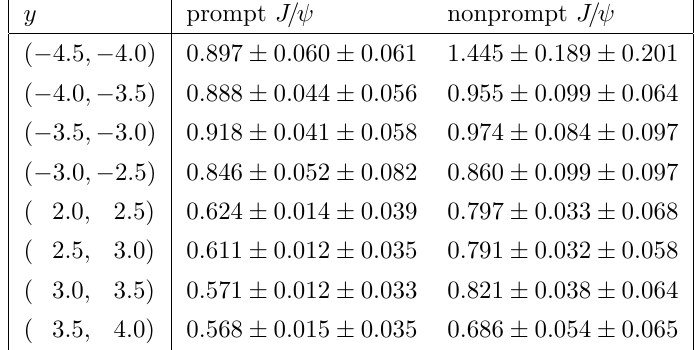
Table 9 . Nuclear modification factor R p Pb as a function of y with p T < 14 GeV/ c . The first uncertainty is statistical and the second is systematic.